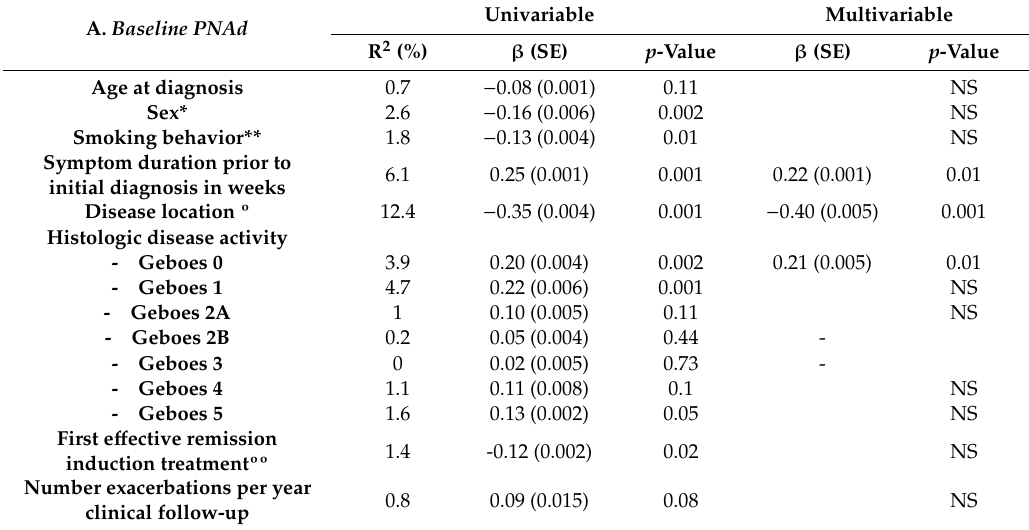
Table 4. Univariable and multivariable analysis of potential variables correlating with the expression of PNAd + (Table 4A) and MAdCAM-1 + (Table 4B) venules as a proportion of ERG + venules at diagnosis. A. Baseline